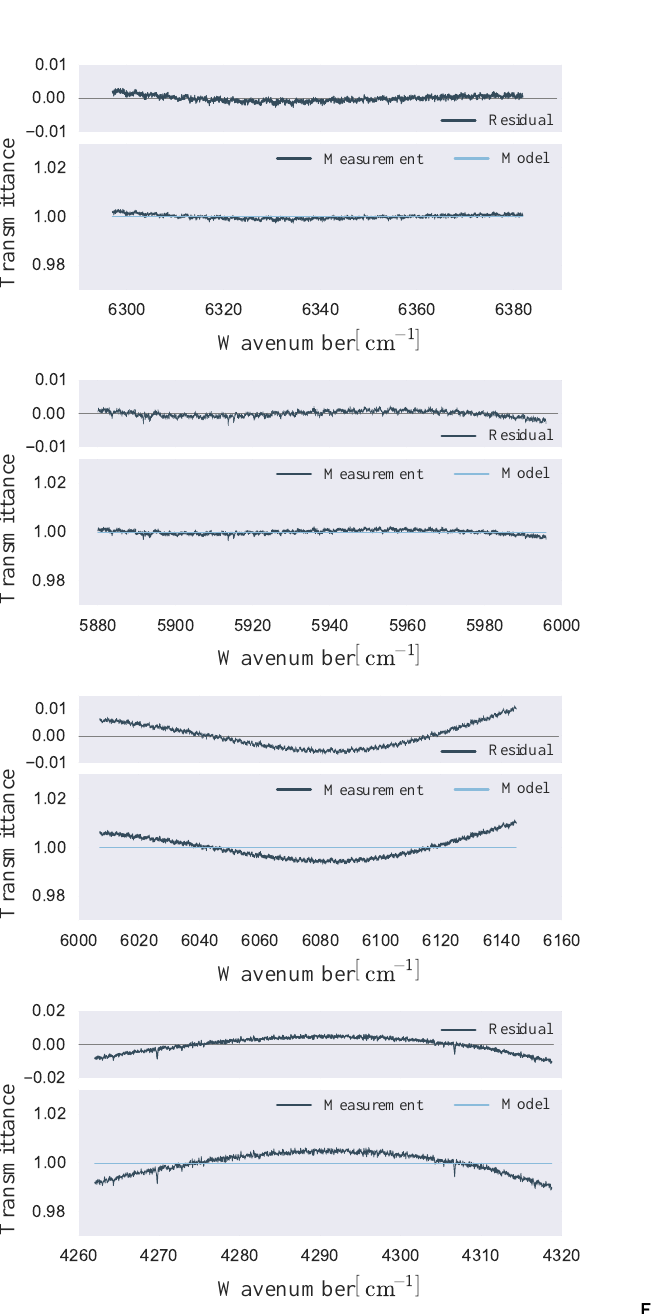
Figure A4. Same as Fig. A1 but using the GGG2014 higher-order continuum fit option. For CO 2 (first panel) N = 3, for CH 4 (cw: 5938.0) (second panel) N = 4, for CH 4 (cw: 6076.0) (third panel) N = 5, and for CO (fourth panel) N = 4 was